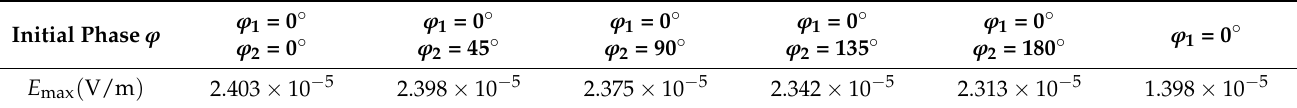
Table 1. Amplitude of ship’s mixed electric